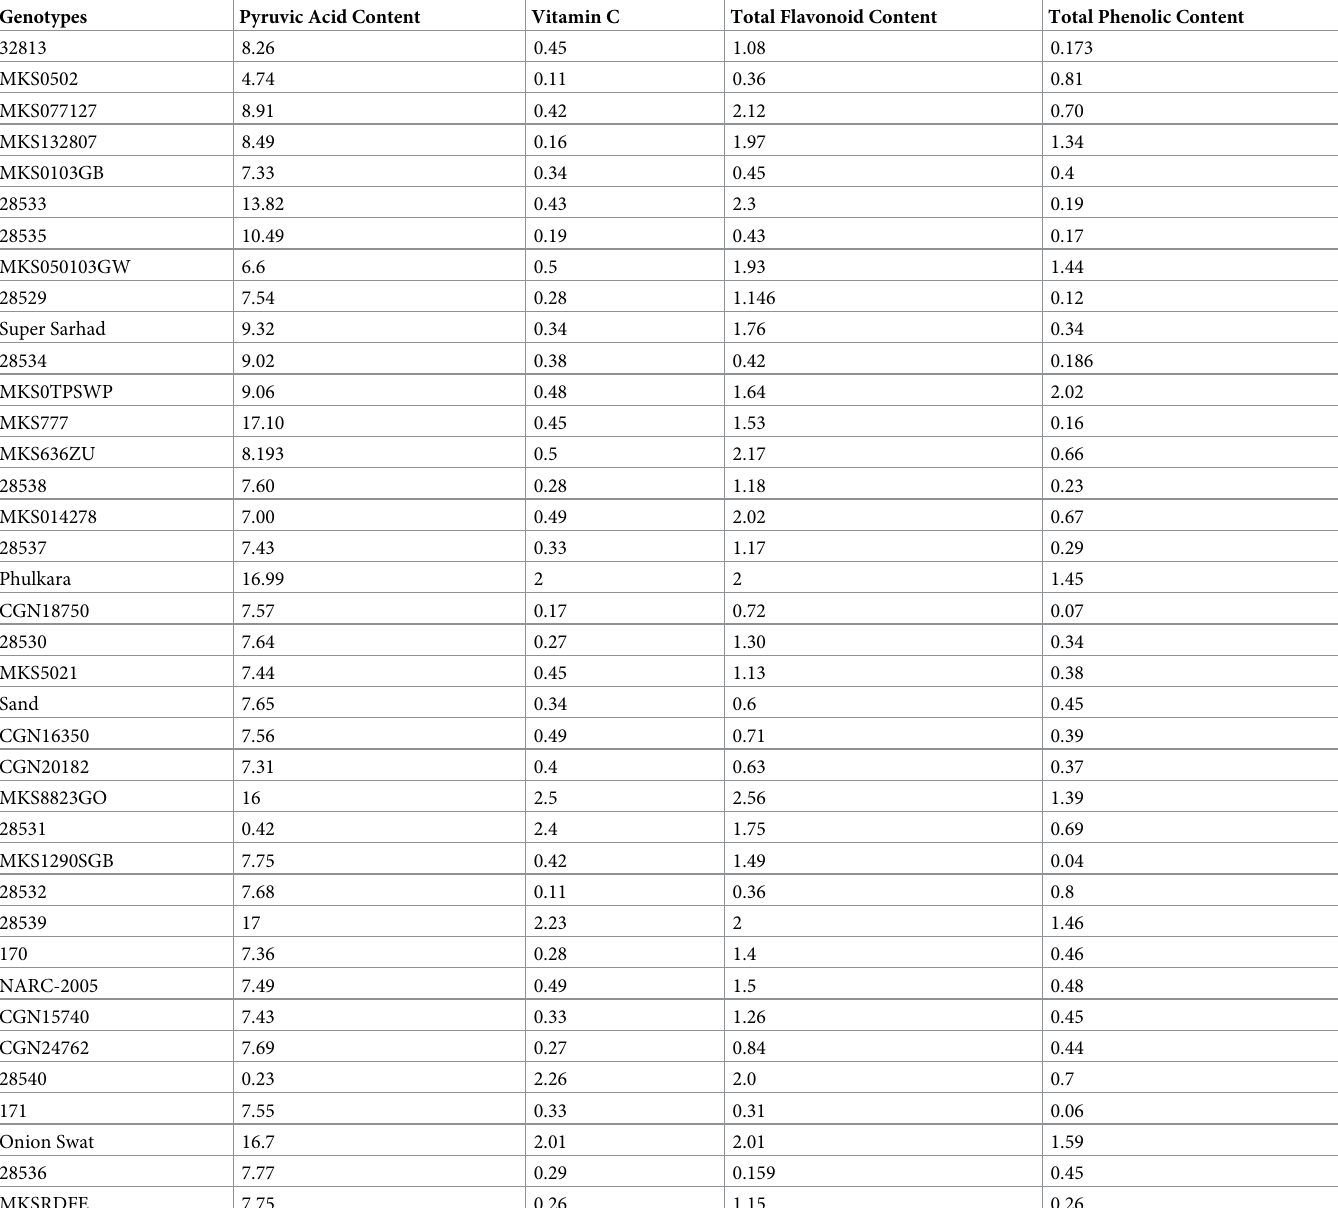
Table 4. Mean performance of 39 onion genotypes for four nutraceutical